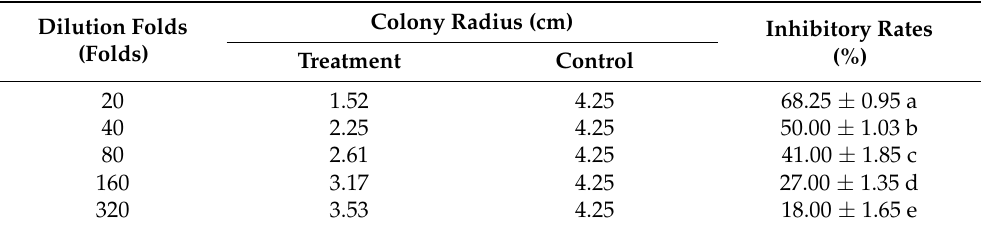
Table 2. Inhibitory activity levels of Trichoderma T6 fermentation products on the growth of the Monilia yunnanensis T8-1 isolate.